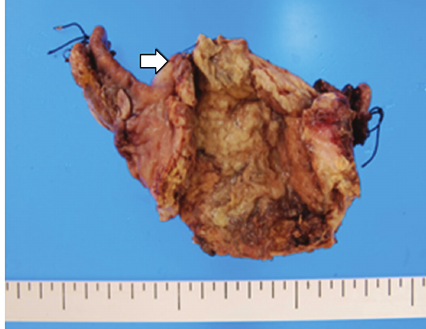
Figure 2: The resected corpus of the uterus. White arrow indicates the perforation site.